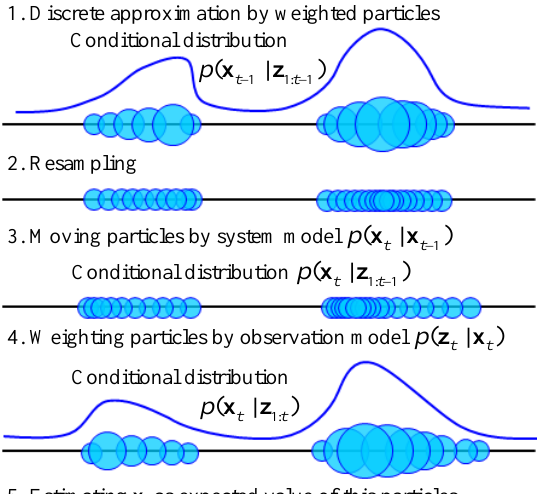
Figure 2. Calculation flow of particle